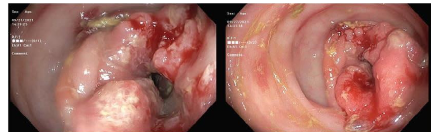
Figure 2: Flexible sigmoidoscopy showing a fungating partially obstructing large mass in the distal sigmoid colon, 25cm away from anal